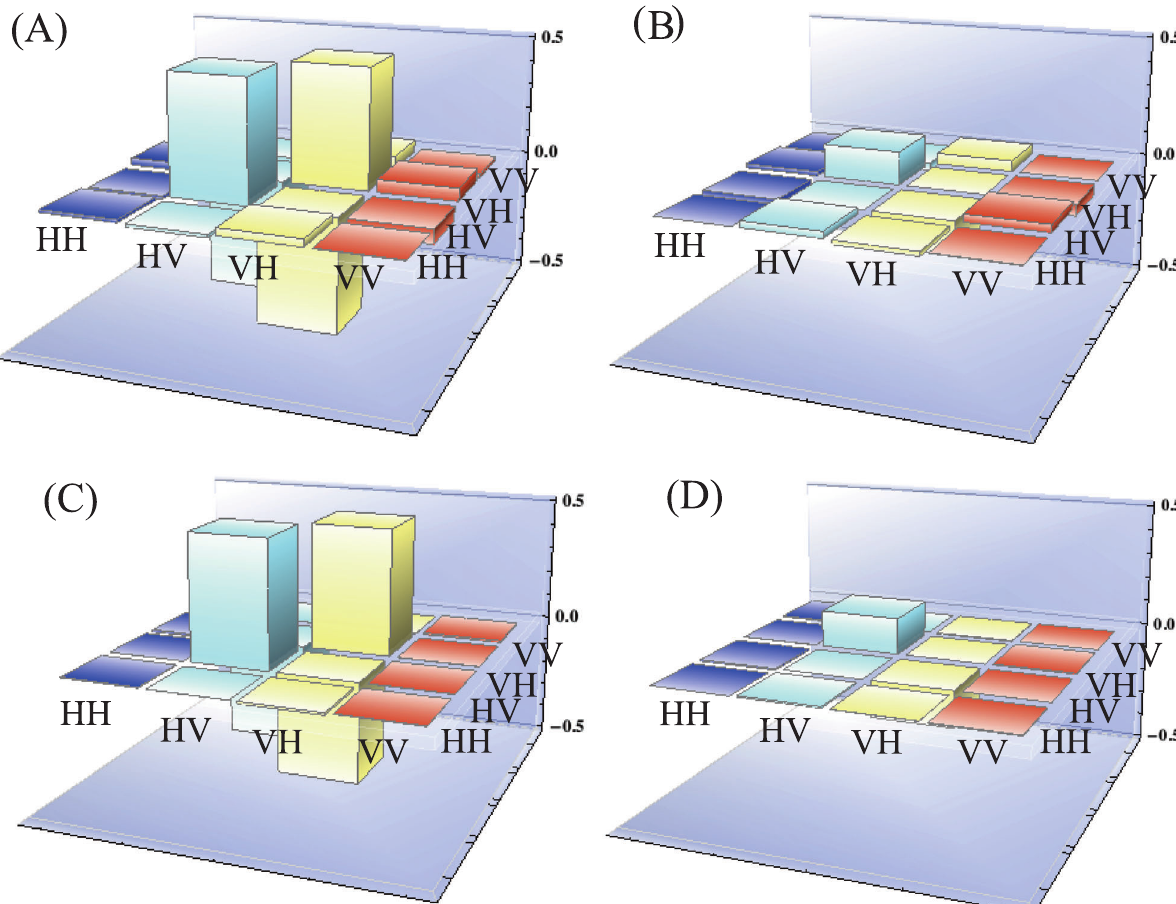
Fig. 3 Real ( a ) and imaginary part ( b ) of the experimental density matrix of the state produced by our source when pumped with pulsed light. Real ( c ) and imaginary ( d ) part of experimental density matrix obtained with CW pump light and no fi lters. Small contributions in the imaginary part are due to non perfect alignment of the axes of the PMFs with the polarization analysis